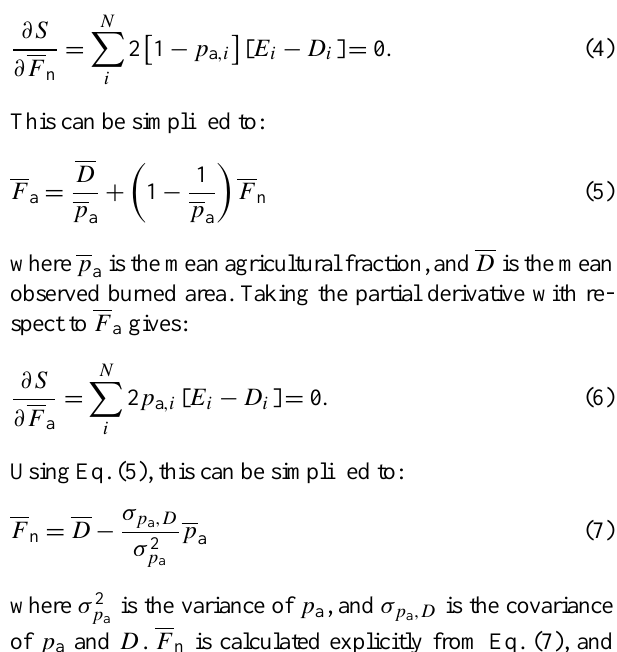
Table 2. Fraction of the total number of grid cells in a region ( N ) that are predominantly non-agricultural vegetation ( g n ) and pre- dominantly agricultural vegetation ( g a